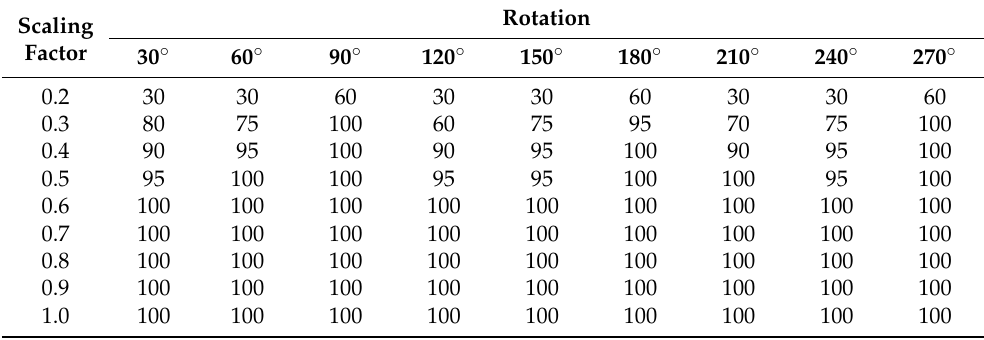
Table 6. The correct recognition rates for a combination of rotation angles and scaling factors for the log-polar DWT-FFT2 method for the 2D aircraft